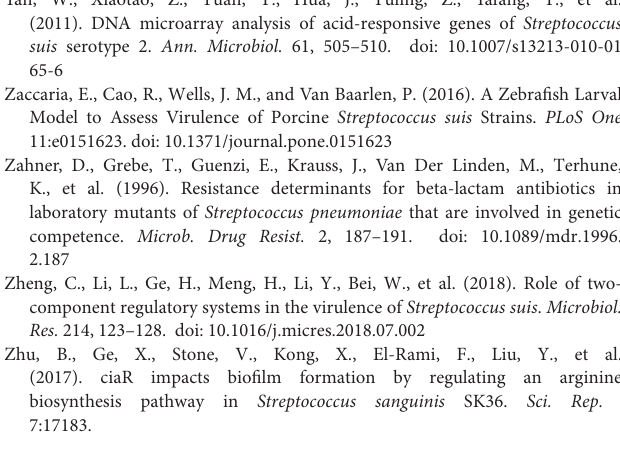
potential conflict of